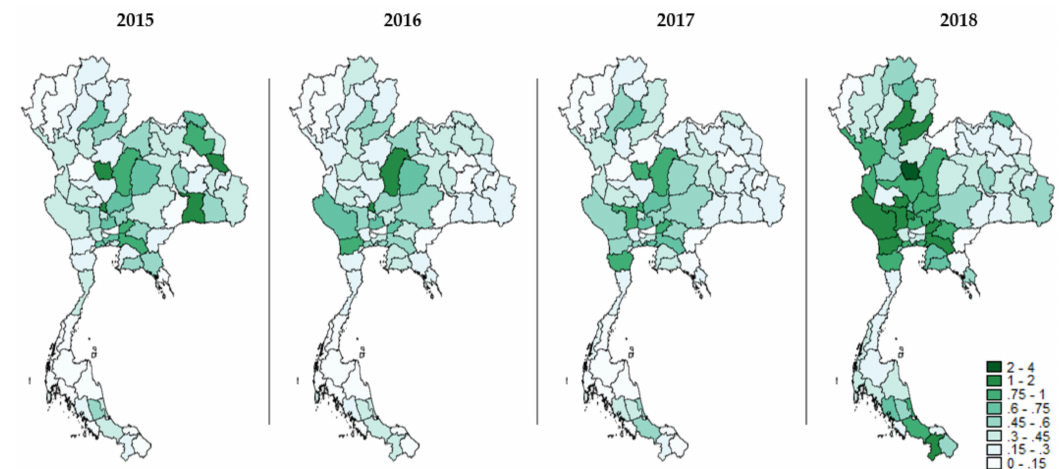
Figure 2. Geographical distribution of the ratio of insured migrants to all migrants in each year during 2015–2018.